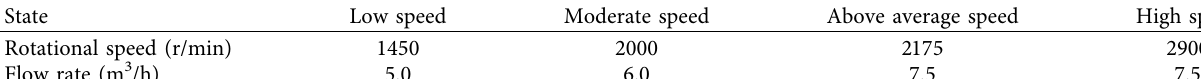
Table 3: Specific working conditions.